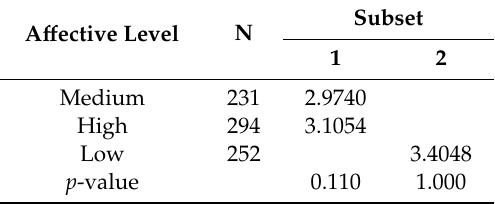
Table 2. Student–Newman–Keuls (SNK) analysis of LDA